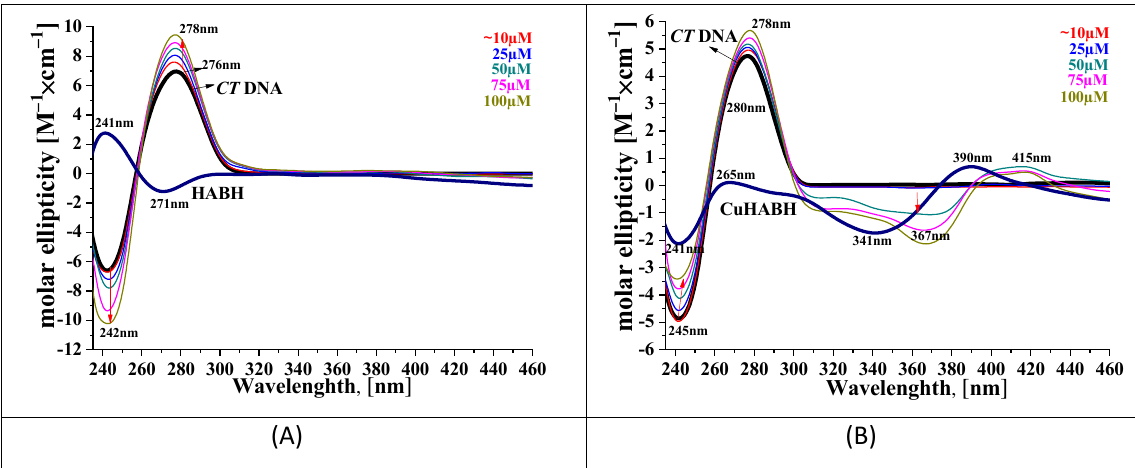
Figure 6. CD spectra of CT-DNA (100 µM) in the presence of: ( A ) HABH, and ( B ) CuHABH at 0–100 µM concentration. The red arrows indicate the direction of change/movement of the spectrum. The black arrows show the CT-DNA spectrum of DNA and its absorbance maximum. The numbers shown on the spectra refer to the absorbance maximum of the emerging bands.